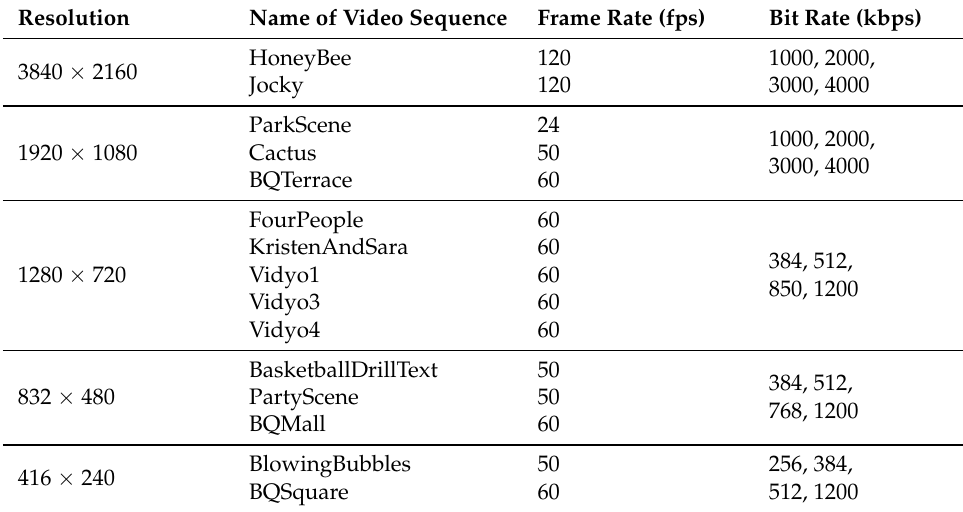
Table 1. Characteristics of Test Video Sequences and Bit